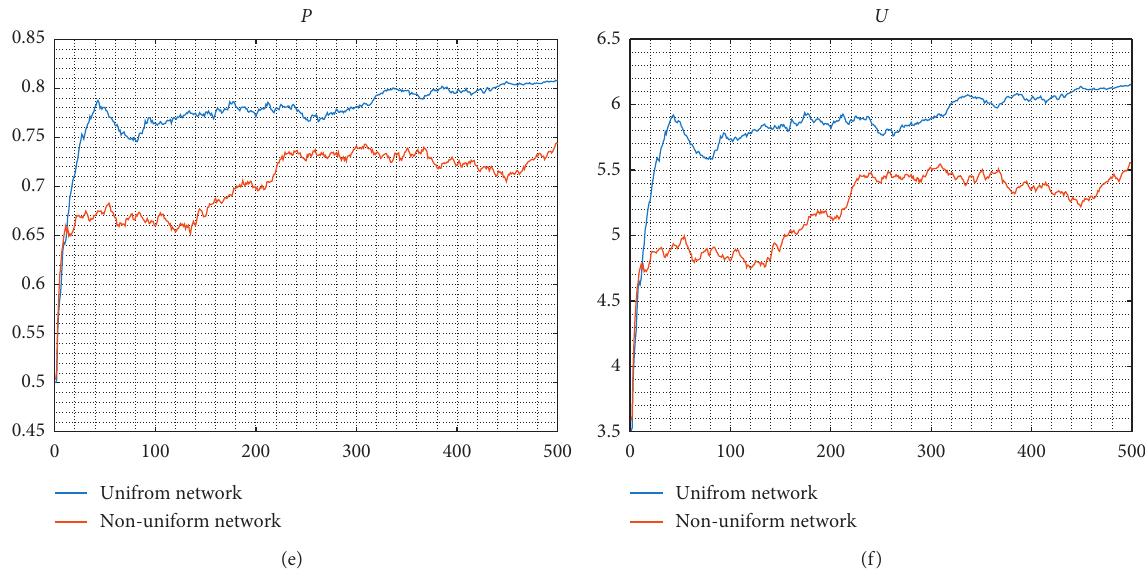
Figure 10: The simulated result considering the change of M and Group Size. (a) P (Experiment 1). (b) U (Experiment 1). (c) P (Experiment 2). (d) U (Experiment 2). (e) P (Experiment 3). (f) U (Experiment